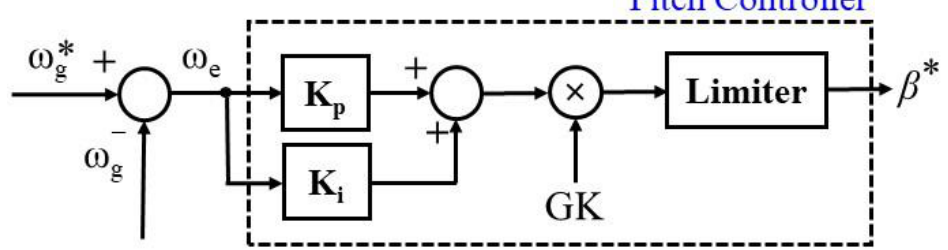
Figure 2. Pitch controller configuration for controlling rated output.